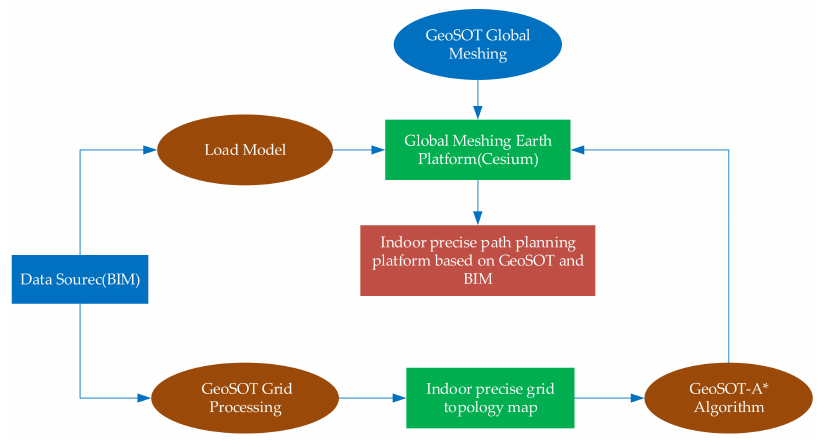
Figure 1. The General idea of the paper.